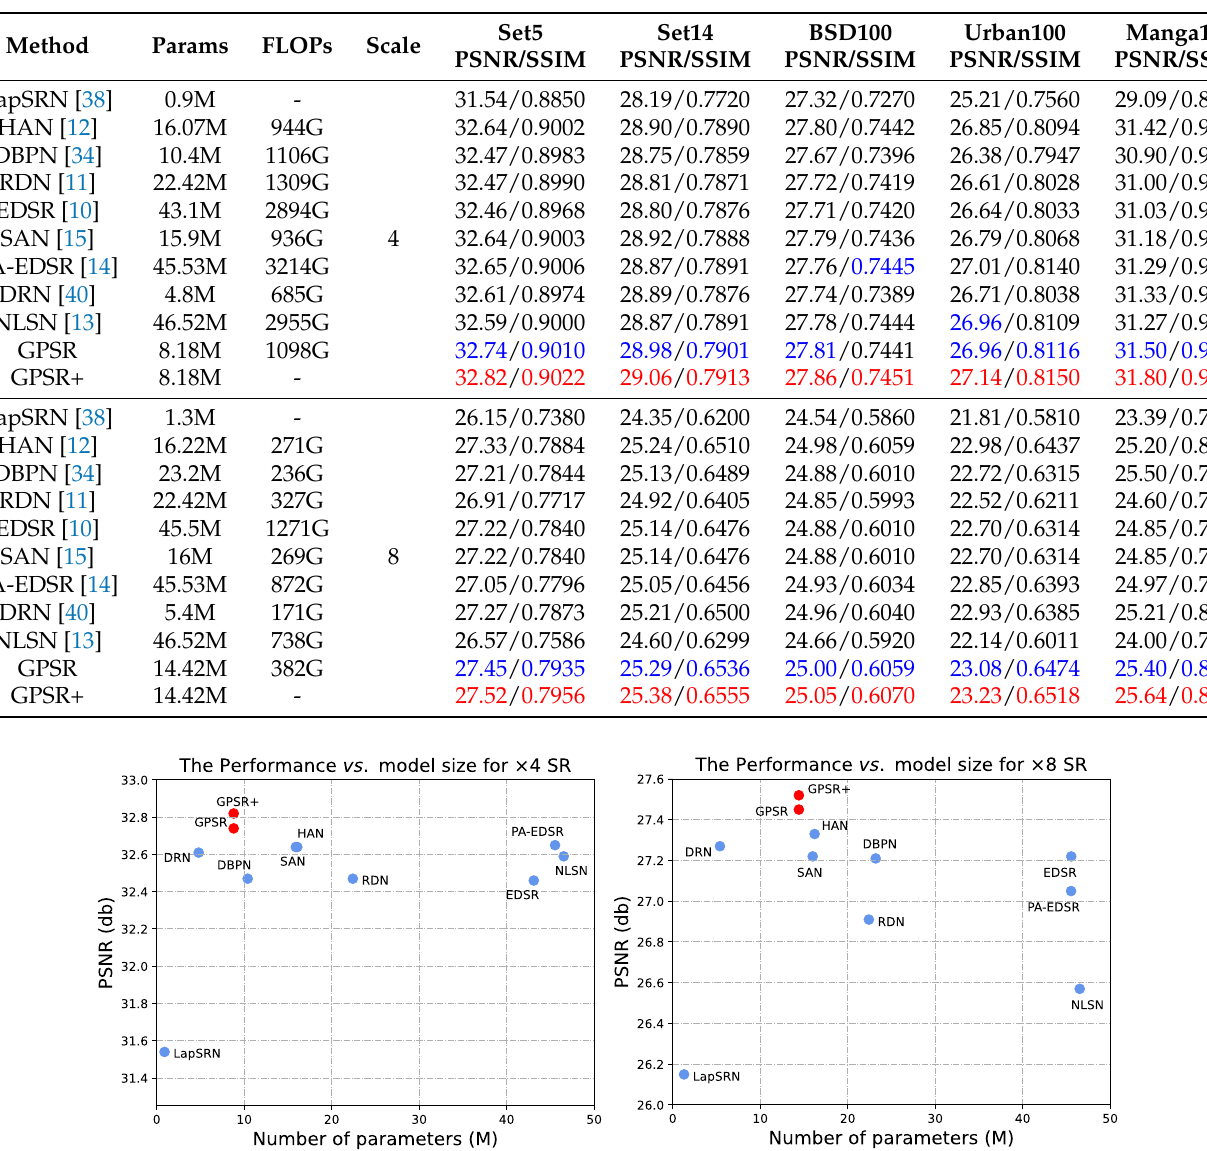
Table 4. Quantitative metrics obtained by various models for SR task with BI degradation model. The optimal and suboptimal metrics are highlighted in red and blue.